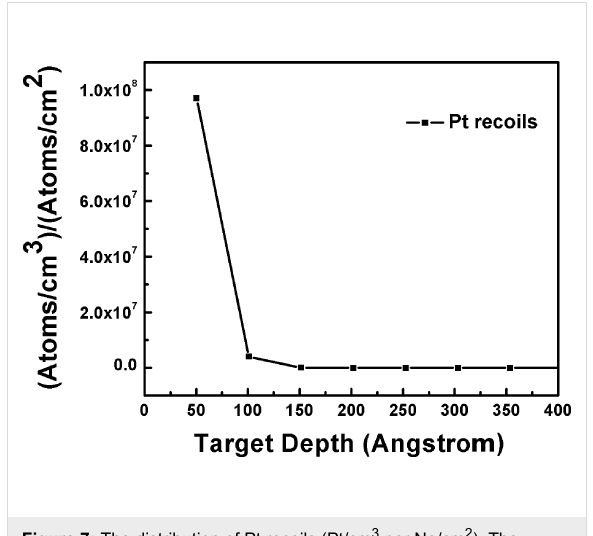
Figure 7: The distribution of Pt recoils (Pt/cm 3 per Ne/cm 2 ). The 50 keV neon ions were irradiated at normal incidence on 5 nm Pt film deposited on the silicon